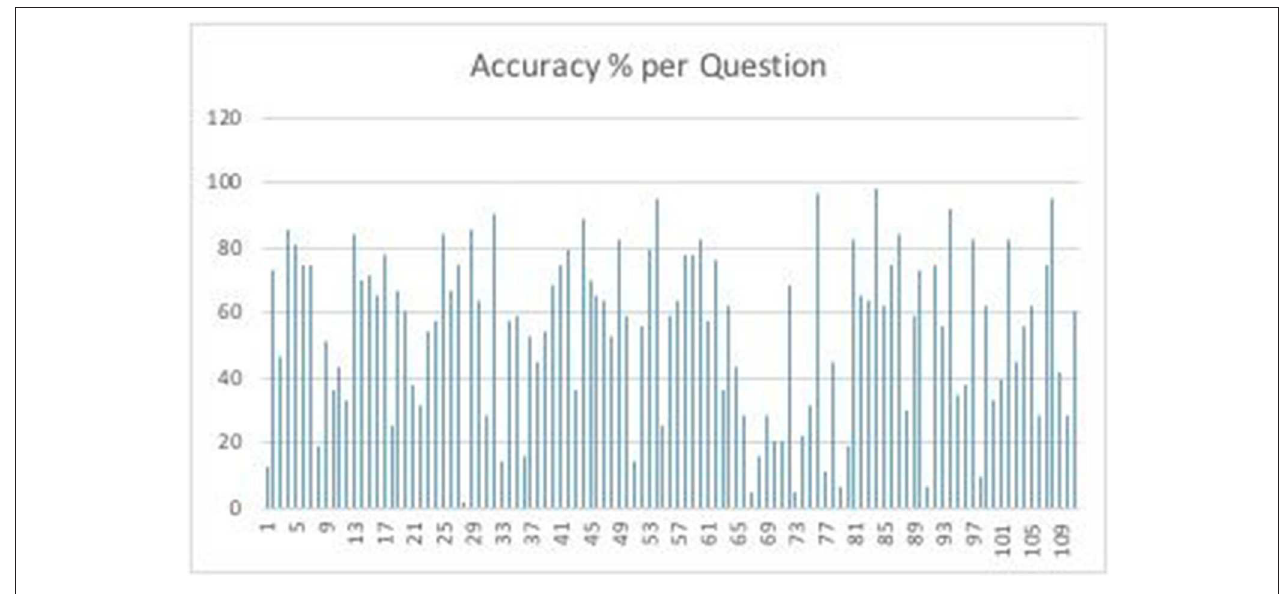
FIGURE 1 | Accuracy per